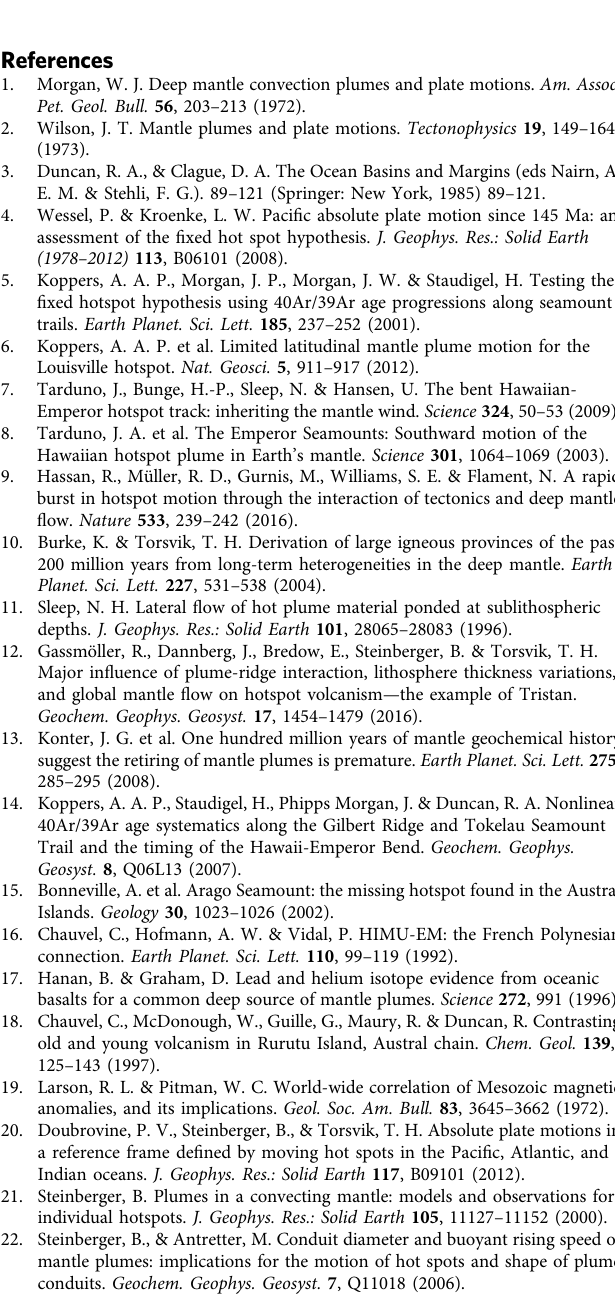
modern tomographic models, no inferences on which tomography or viscosity models best fi t the observed data are presented. However, plumes rooted above the transition zone consistently did not reproduce fi rst-order observations of relative plume motion directions. In addition, if just the Rurutu hotspot is generated near the transitional zone while the other hotspots are generated near the CMB, then the motions tend not to reproduce fi rst-order observations either (Fig. 3). Data availability . All data for 40 Ar/ 39 Ar age determinations are available both in the Supplementary Information and in the online EarthRef.org Digital Archive (https://earthref.org/ERDA). All metadata associated with the RR1310 cruise is available upon request from OSU ’ s Marine and Geology Repository